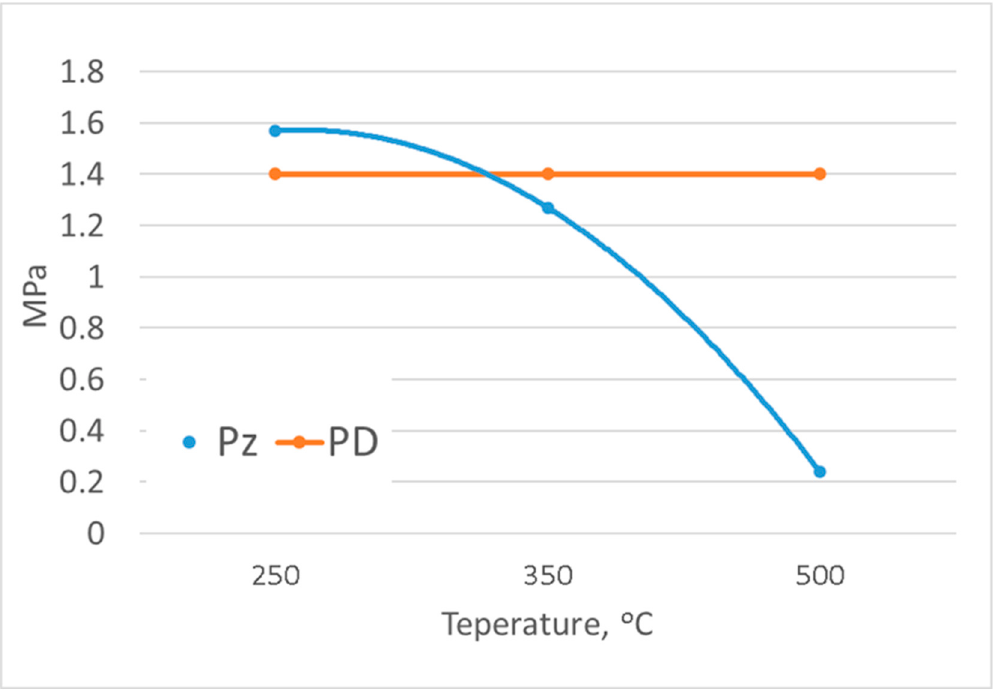
Figure 19. Dependence of the driving and retarding forces of recrystallization from the annealing temperature.